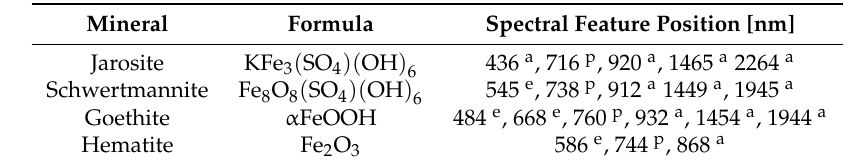
Table 1. Main AMD proxies proposed of this study. Their specific absorption features are taken from several sources [8,10,25–28] and given in nm.